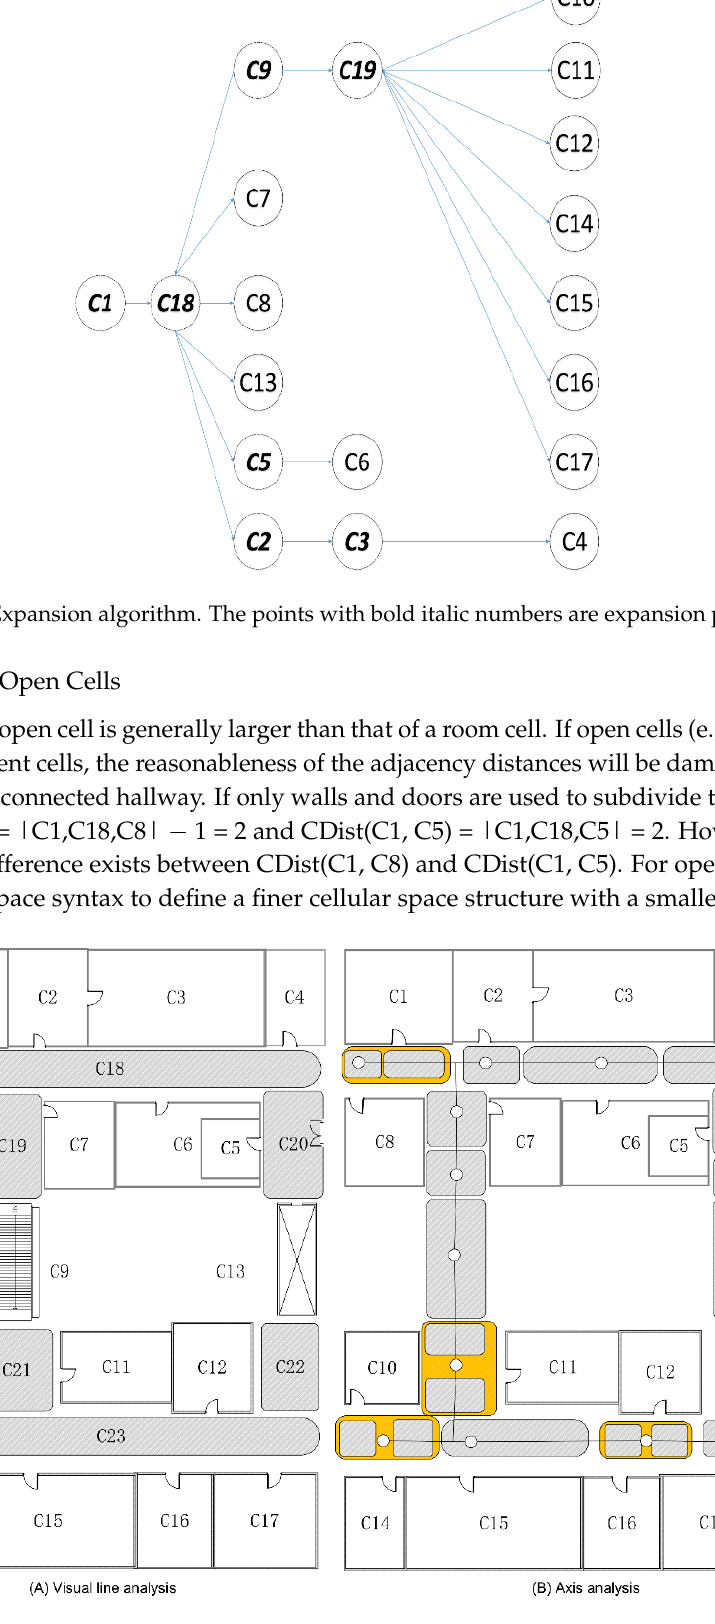
Figure 8. ( A,B ) Visual line analysis and axis analysis.